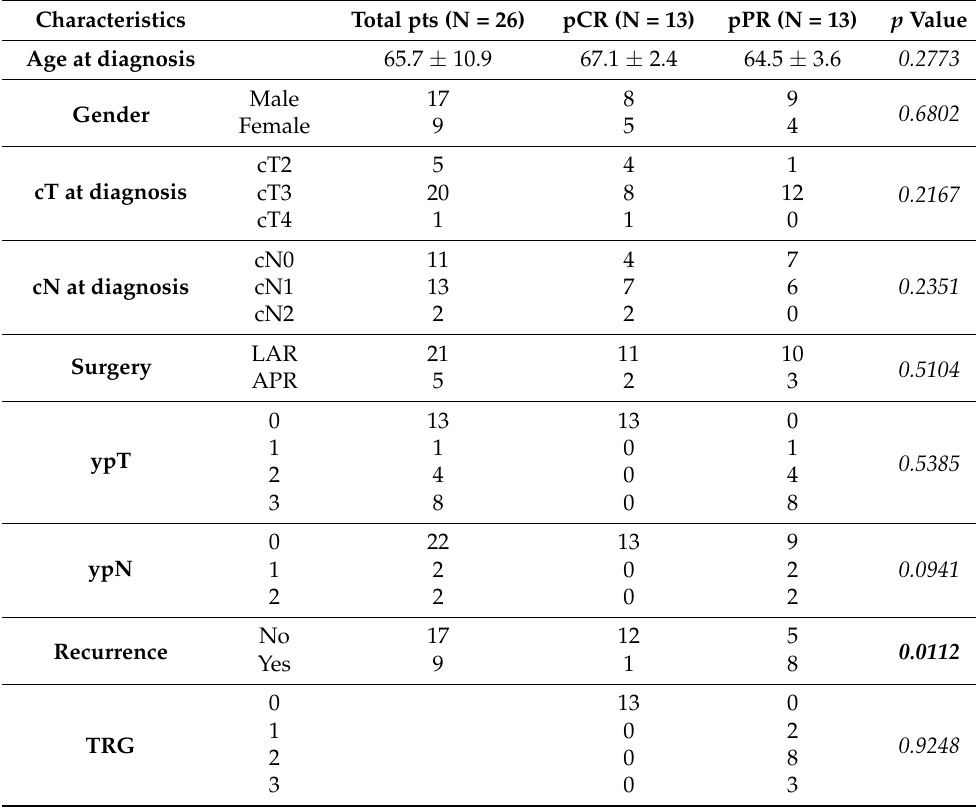
Table 1. Clinical–pathological characteristics of the 26 patients included in the